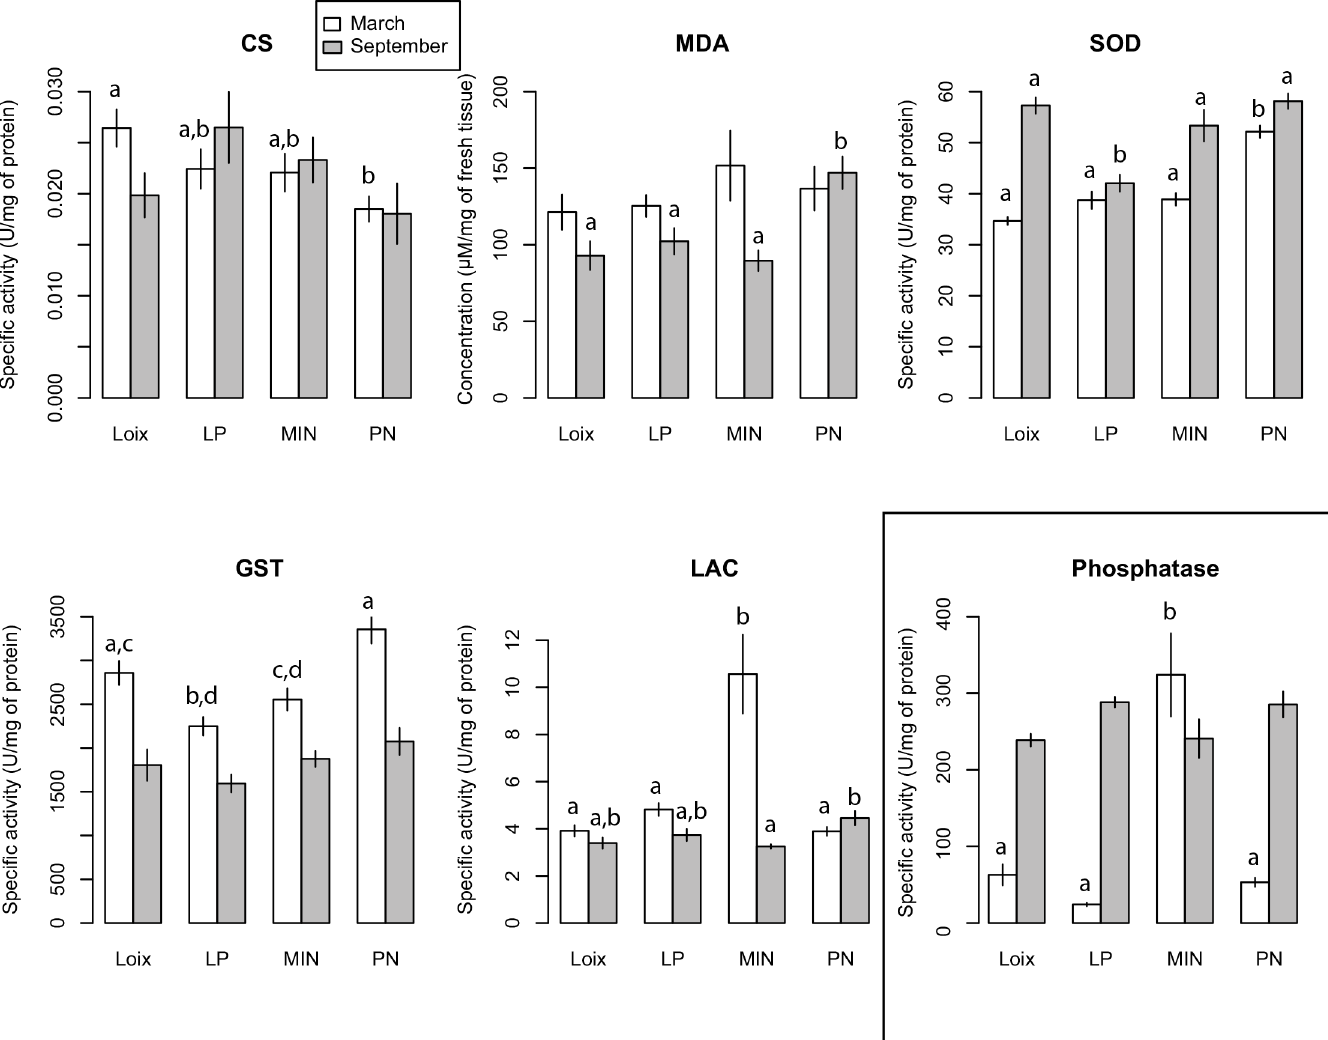
Fig 4. Biomarkers and phosphatase activity assessed in the final fraction of Mimachlamys varia digestive glands or muscle (see Material and Methods) for March and September 2014 from Loix-en-Ré (Loix), Les Minimes (MIN), Port-Neuf (PN) and Les Palles (LP). CS: Citrate synthase activity, MDA: MDA contents, SOD: SOD activity, GST: GST activity, LAC: Laccase activity. Note that the barplot for phosphatase activity is separated by a frame as this activity was measured using 10 pooled individuals (see Material and Methods). Sampling seasons (March and September) are color-coded and are shown on the same barplot. Values represent mean ± standard error (n = 10 individuals per site for biomarkers; n = 3 replicate measurements of the pool for Phosphatase activity). Within each season, bars that do not differ significantly (p > 0.05) share the same letters. No letters are shown above bars when there was no significant statistical difference among